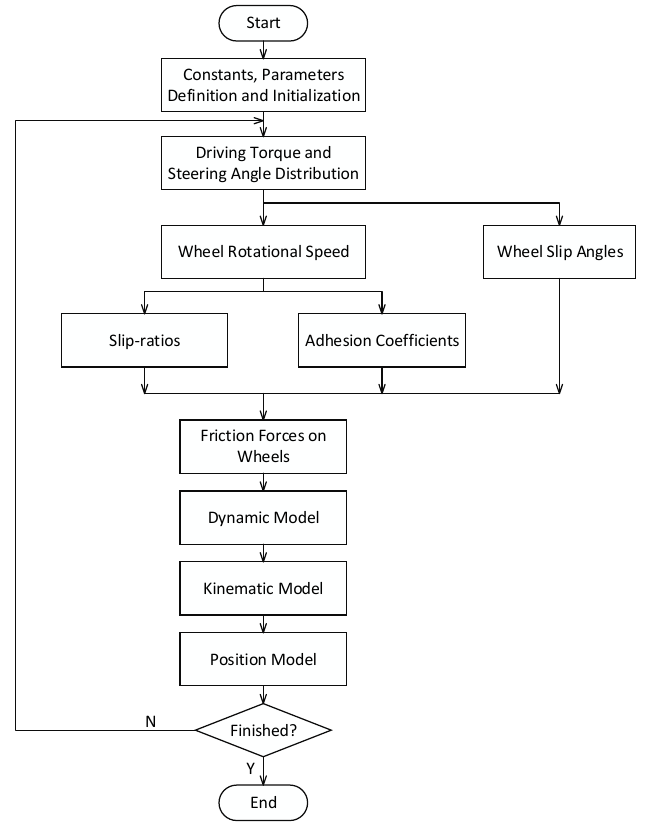
Figure 8. Program Flowchart for the Signal Hardware-In-the-Loop (HIL) Simulation